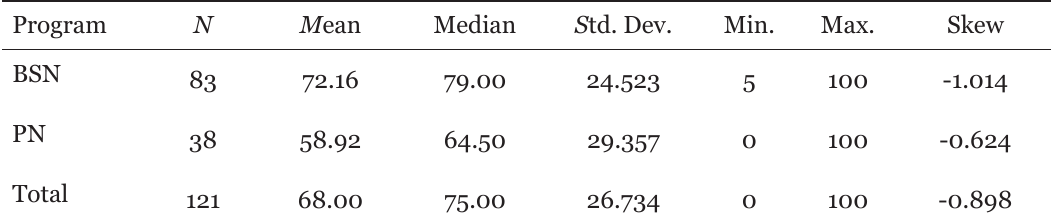
Self-Efficacy Scores – Program Comparison (Faculty–Student Combined) Program